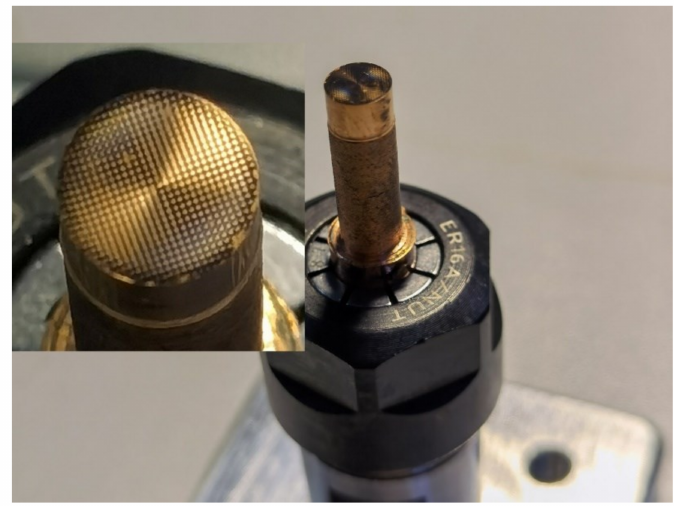
Figure 8. Fabricated sinusoidal modulation microstructures on a curved copper surface.